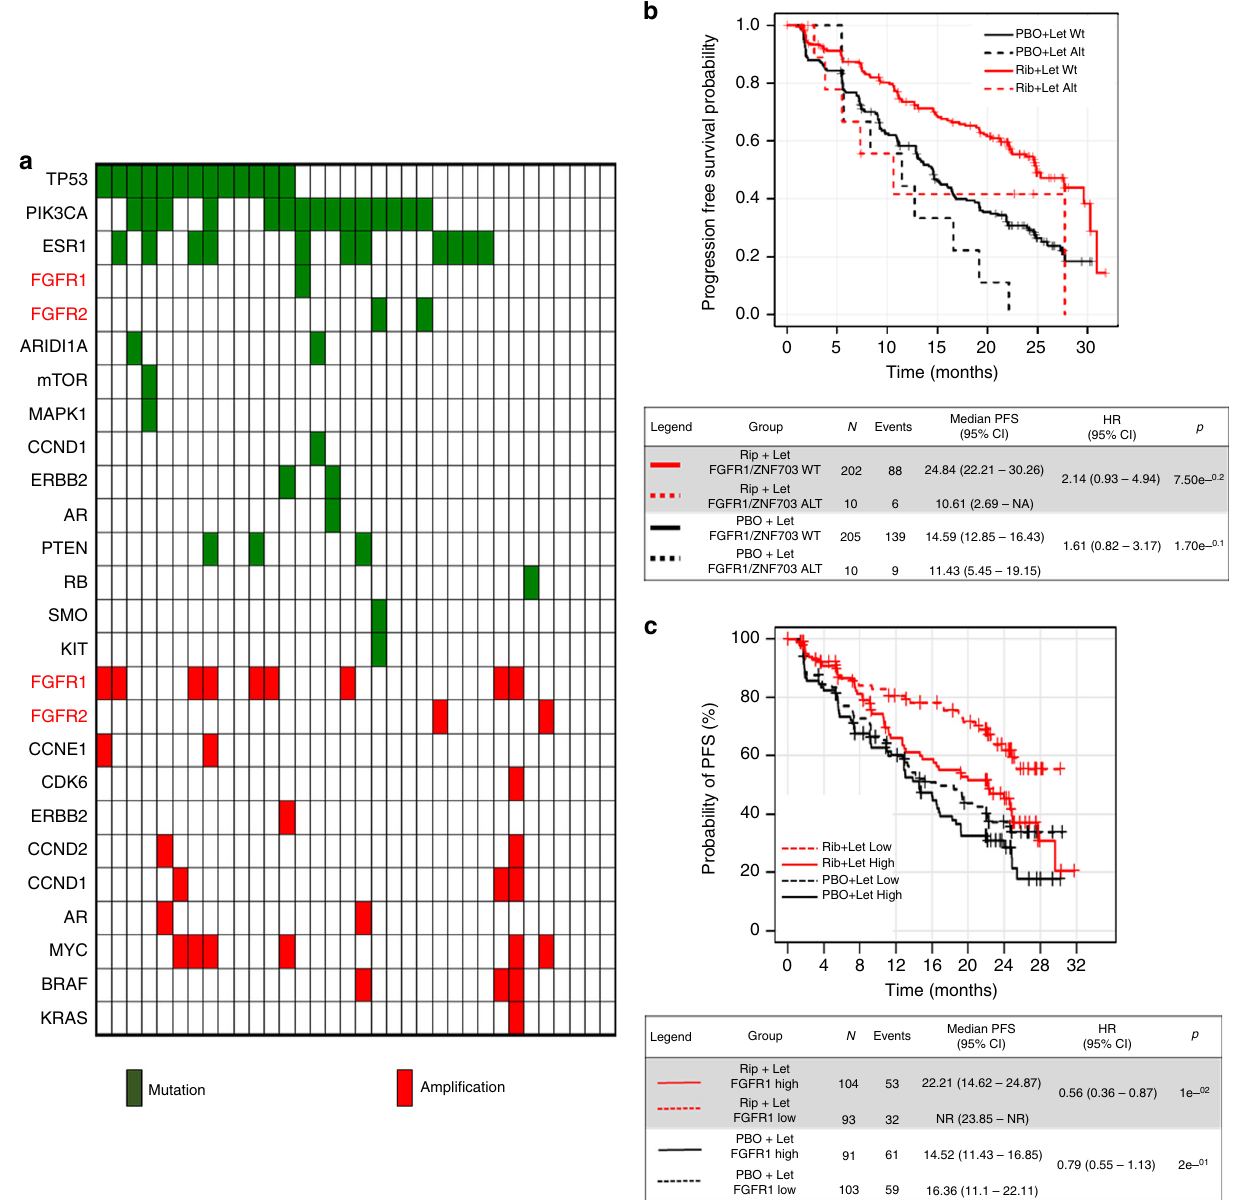
Fig. 7 FGFR alterations correlate with poor outcome in ER + breast cancers treated with CDK4/6 inhibitors and endocrine therapy. a Landscape of alterations in plasma tumor ctDNA from 34 patients progressing on palbociclib. b PFS in patients in the MONALEESA-2 trial of letrozole (Let) plus ribociclib (Rib) vs. letrozole plus placebo (PBO). Among patients treated in the investigational arm with letrozole plus ribociclib, those with detectable FGFR1/ZNF703 ampli fi cation (ALT) in ctDNA had a PFS of 10.61 months vs. 24.84 months in patients without FGFR1/ZNF703 ampli fi cation. c PFS in patients in MONALEESA-2 as a function of FGFR1 mRNA in archival tumor biopsies. Patients with cancers with high FGFR1 mRNA treated with letrozole/ ribociclib exhibited a shorter PFS compared to patients with tumors with low FGFR1